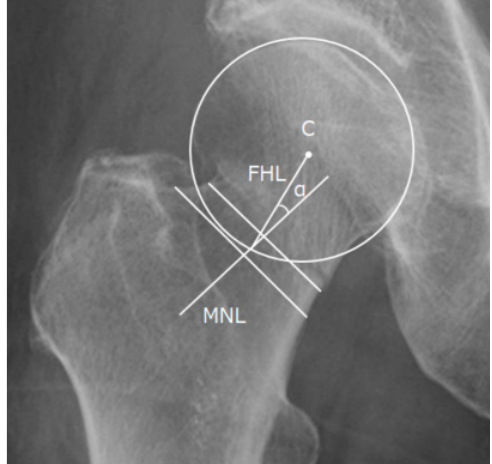
Figure 3. Valgus tilt measurement using preoperative anteroposterior radiographs. First, the mid- neck line (MNL) was drawn through the center of two lines across the residual mid-femoral neck; the first line was drawn at the narrowest part of the residual mid-femoral neck, and a second parallel line was drawn 5 mm distal to the first line. Second, the femoral head line (FHL) was drawn from the center (C) of the femoral head circle to the point where the MNL crossed the femoral head circle. Lastly, the valgus tilt ( ⍺ ) was the angle formed by the MNL and FHL.